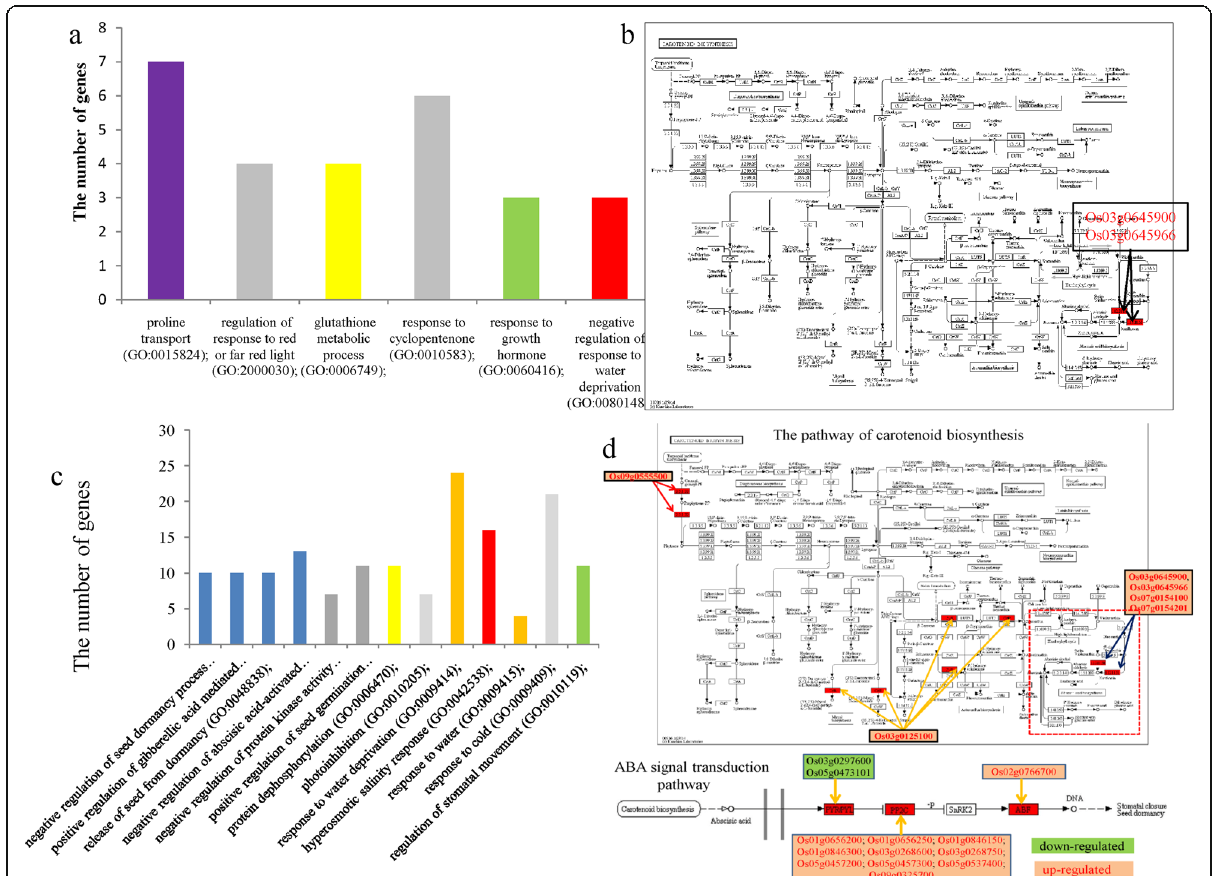
Fig. 5 The enrichment analysis of overlapped DEGs between the germination and seedling stages. a : Sixty-nine DEGs were enriched in biological processes between the germination and seedling stages; b : 69 enriched DEGs overlapped in the metabolic pathways between the germination and seedling stages; c : 164 DEGs were enriched in biological processes that were shared among three sampling points at the seedling stage; b: 164 DEGs were enriched in metabolic pathways that were shared among three sampling points at the seedling